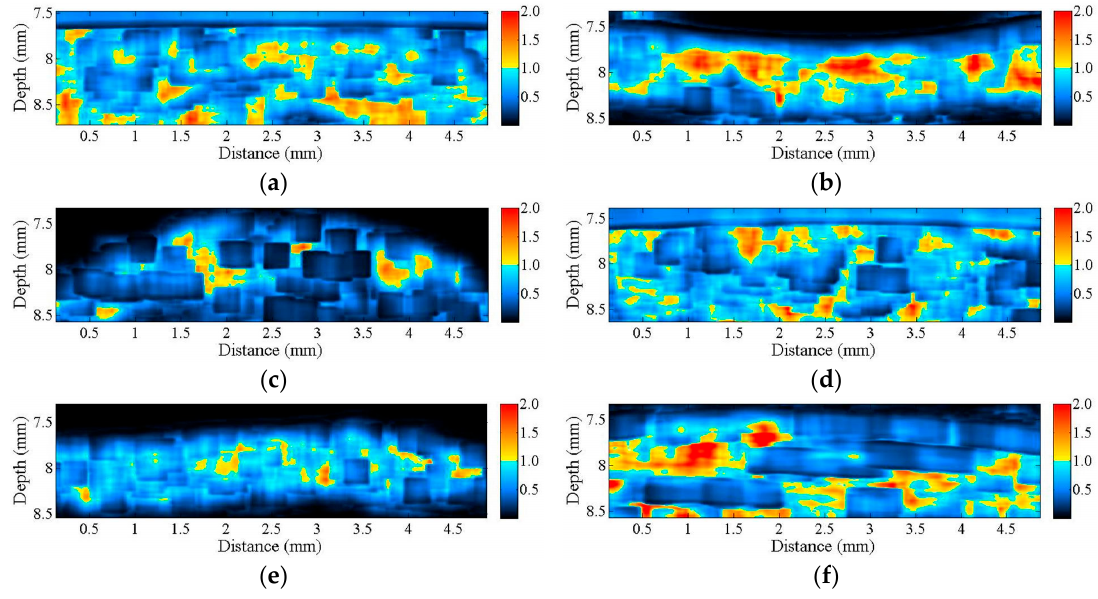
Figure 6. Nakagami images corresponding to the B-mode images in Figure 2 of ( a ) hypodermis; ( b ) A1 pulley; and ( c ) SDFT in the sagittal plane; and of ( d ) hypodermis; ( e ) A1 pulley; and ( f ) SDFT in the transverse plane.